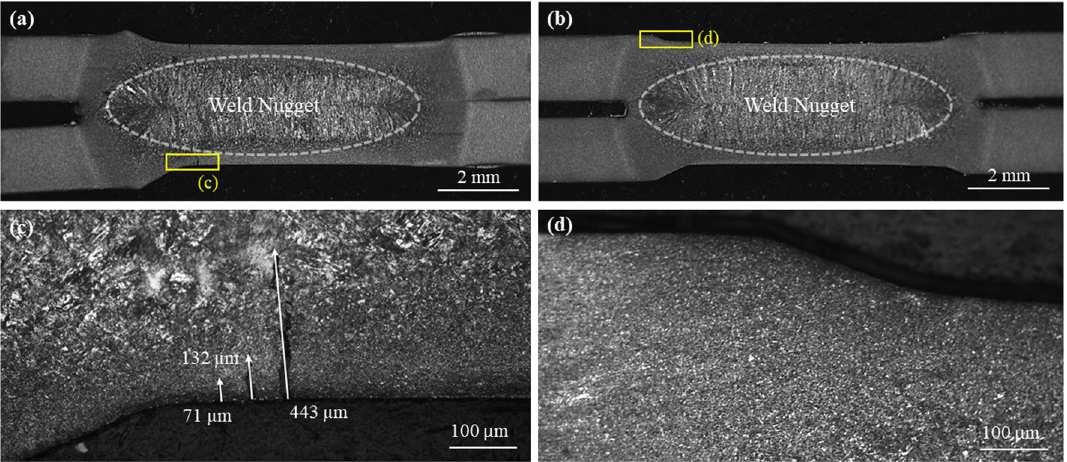
using the selected and d arbitrary cutting planes. Examples of how crack depth was measured may be seen on inset ( c